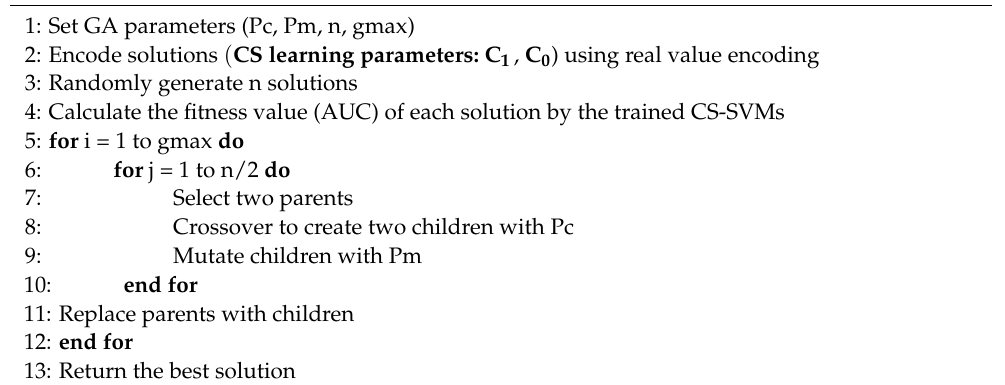
Algorithm 1. Combining GA-CS-SVM for optimizing the CS learning